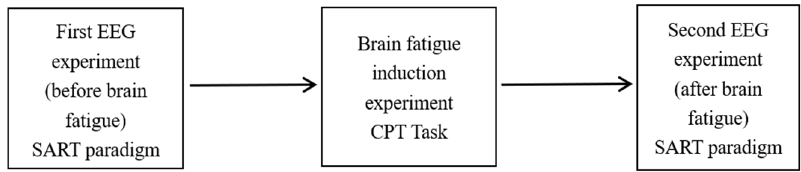
Figure 4. Flow chart of experimental sequence.